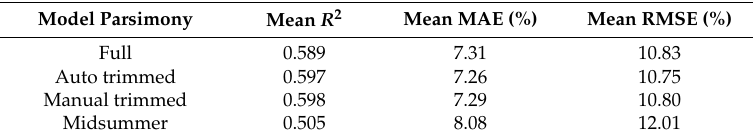
Table 7. Mean model performance by model parsimony for all PFTs and other cover types, North Slope,